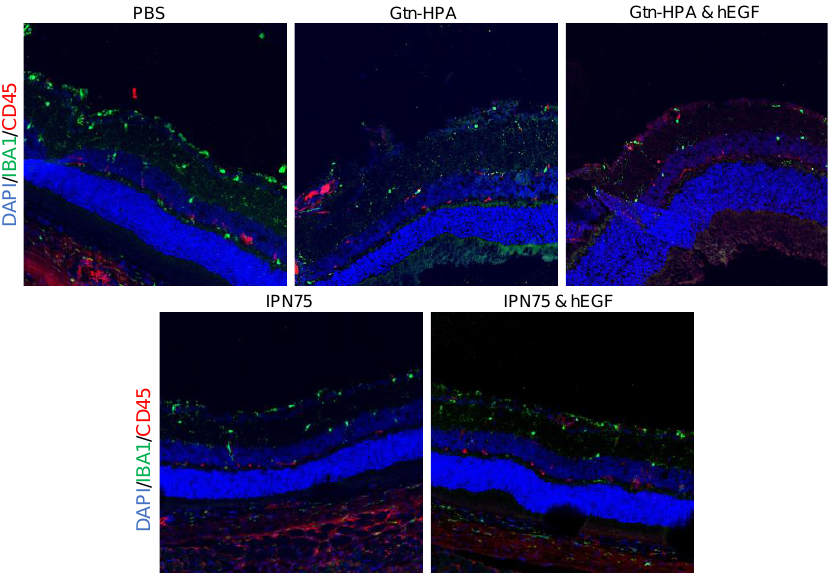
Figure 12. Immune response staining in xenografts. Images taken with fluorescence microscopy to identify leukocytes and immune cell marker expression. All images were taken at 63X magnification. Immunostaining of all groups (PBS, Gtn-HPA, Gtn-HPA and hEGF, IPN75, and IPN75 and hEGF) for CD45 (APC) identify leukocytes, with IBA1 (FITC) identifying microglial